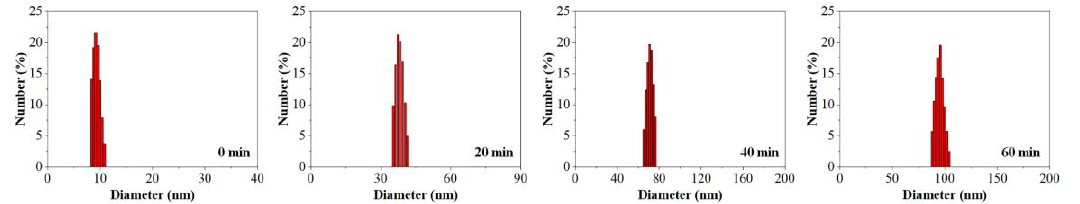
Figure 3. Diameter changes of the YFNP in the presence of target miR-21 at different time intervals (0 – 60 min). (0–60 min).